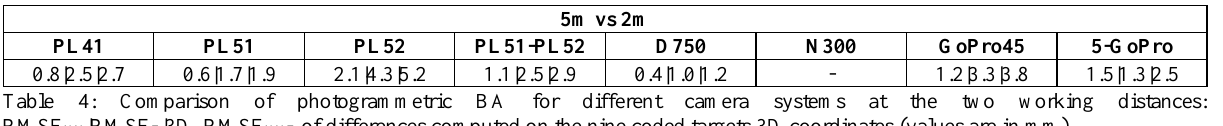
Table 3: Results from self-calibrating BA in free network mode.